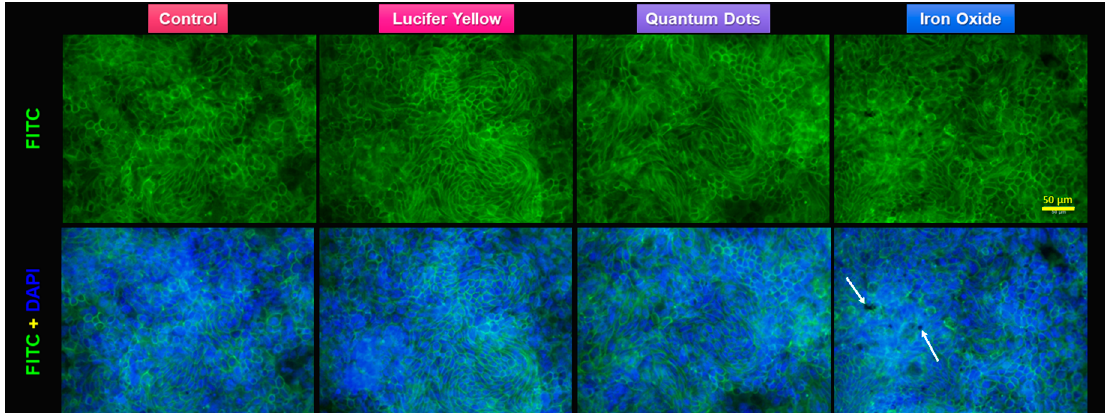
Figure 7. Fluorescence staining of the actin cytoskeleton of Caco-2/HT29-MTX monolayer after the 3-h transport study. F-actin is marked with fluorescein isothiocyanate (FITC)-phalloidin (green). Nuclear counterstain with 4 ′ ,6-diamidino-2-phenylindole (DAPI) (blue). Note the aggregates of α -Fe 2 O 3 nanoparticles ( white arrows ) on the top of the cells.